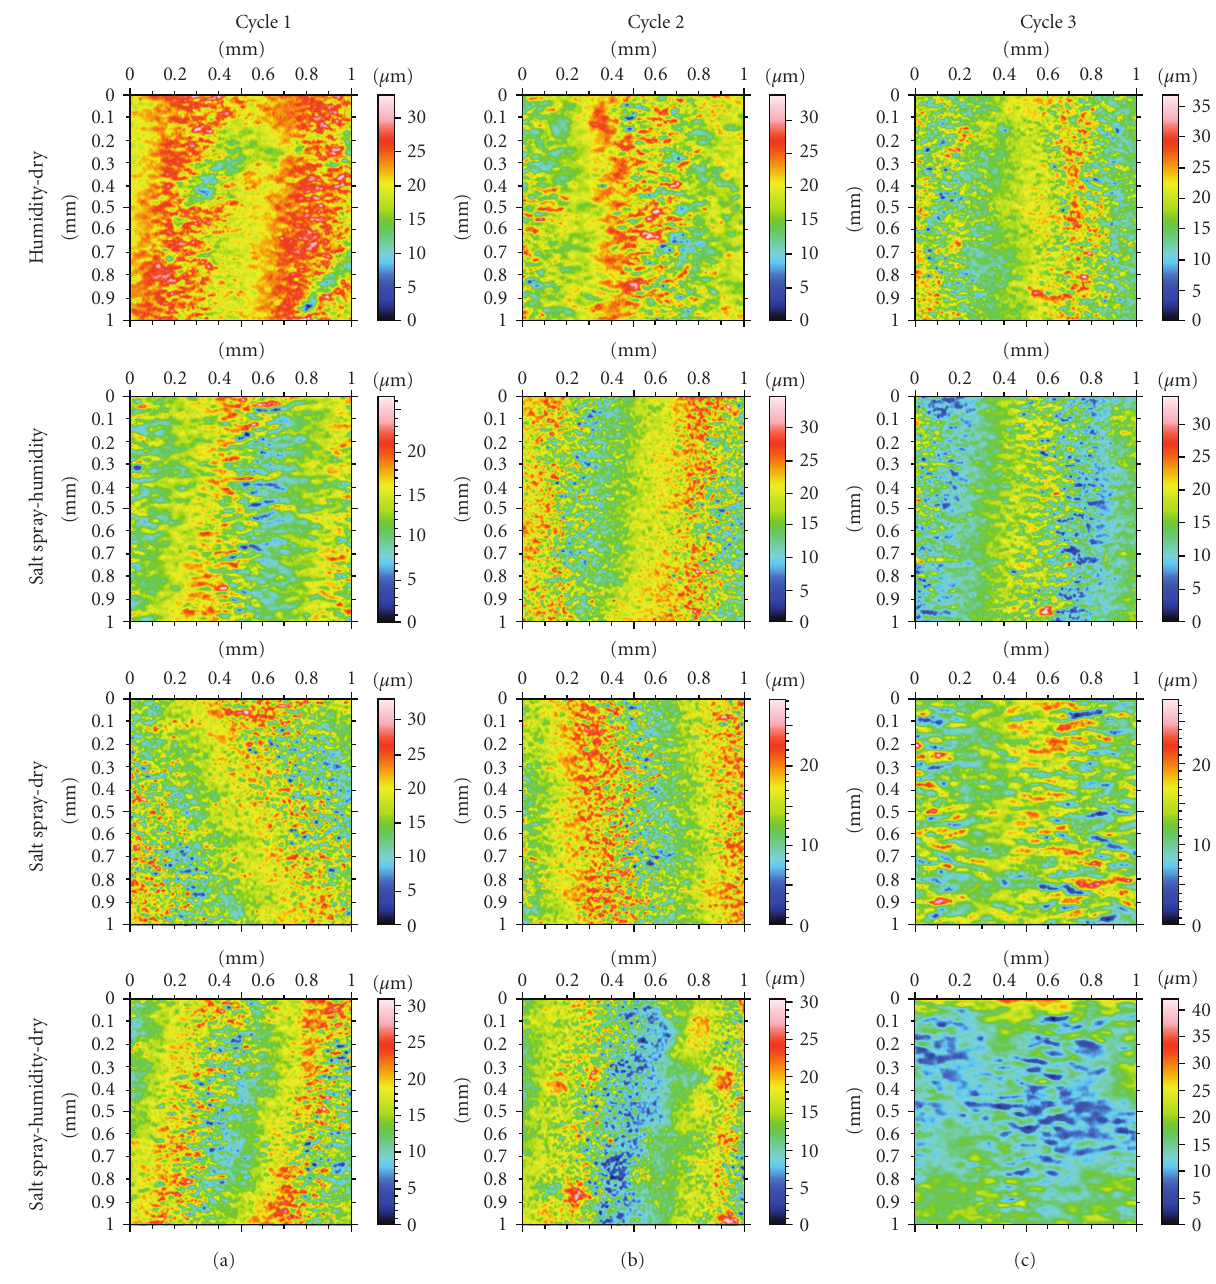
Figure 8: 2D Laser Profilometry of the AE44 coupons arranged by test condition based on cycle number. The blue colors correspond to the lowest surface values, while the pink colors represent the highest surface values. Notice the increasing amount of intergranular corrosion following each cycle, as denoted by an increase in the connecting blue areas and a decrease in the red